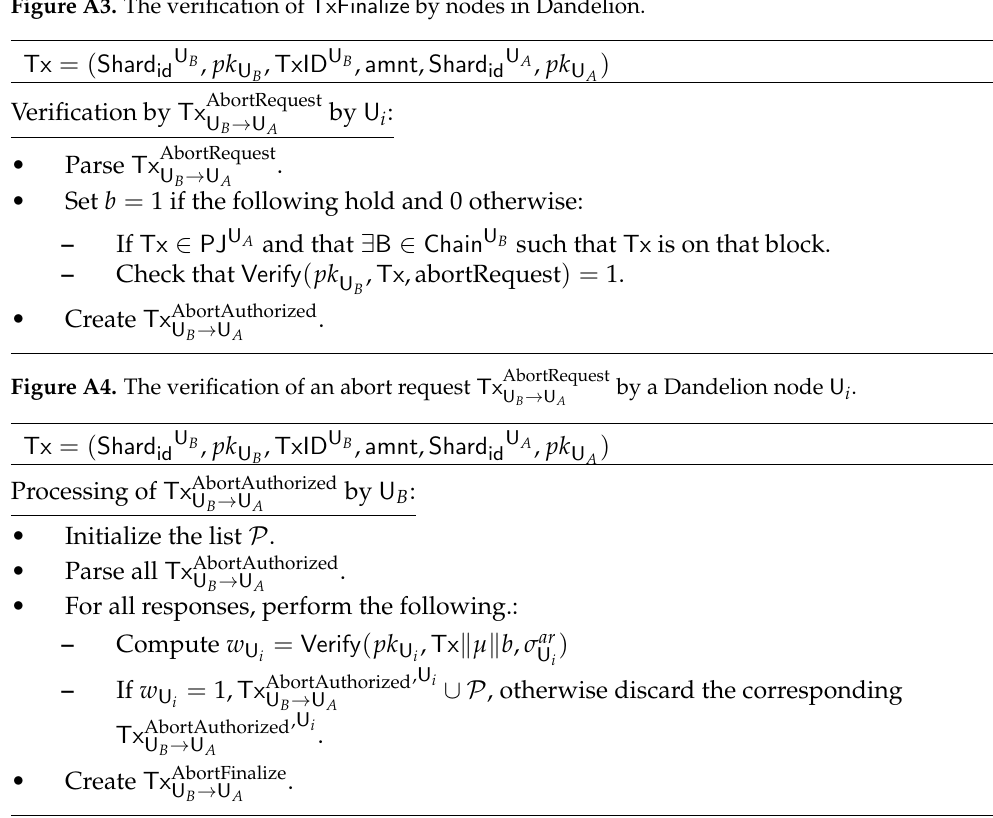
Figure A5. The process for how U B responds to the authorization answers, Tx AbortAuthorized U the